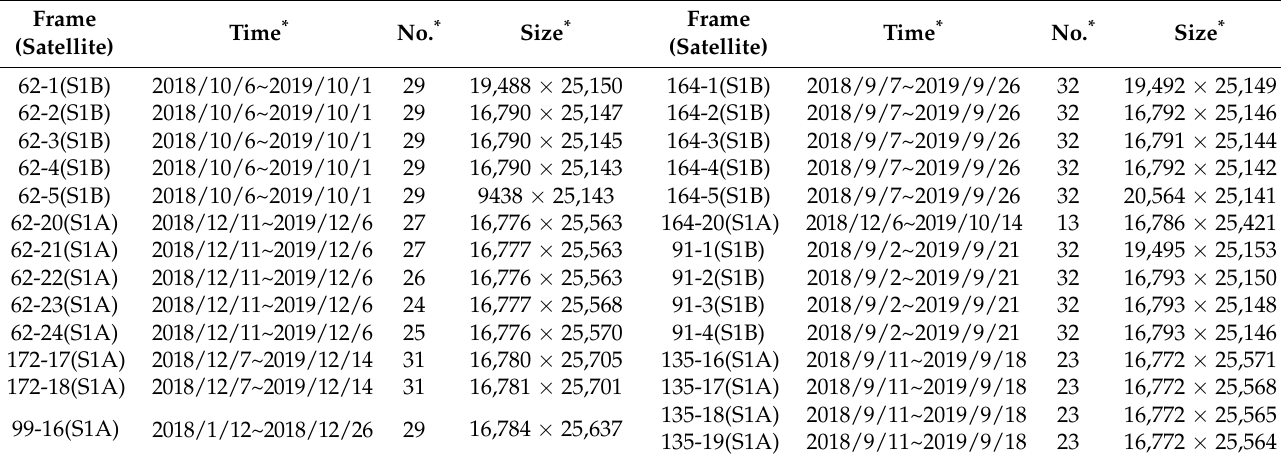
Figure 3. The mosaic image of σ 0 mean in Thailand. Table 1. Information of time series Sentinel-1